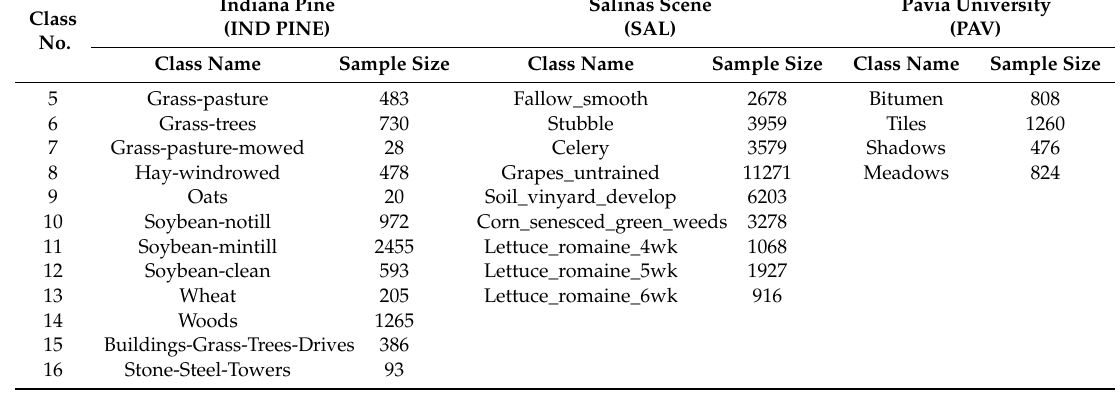
Table 2. Sample size (number of pixels) of each class in datasets from Group II. Class No.